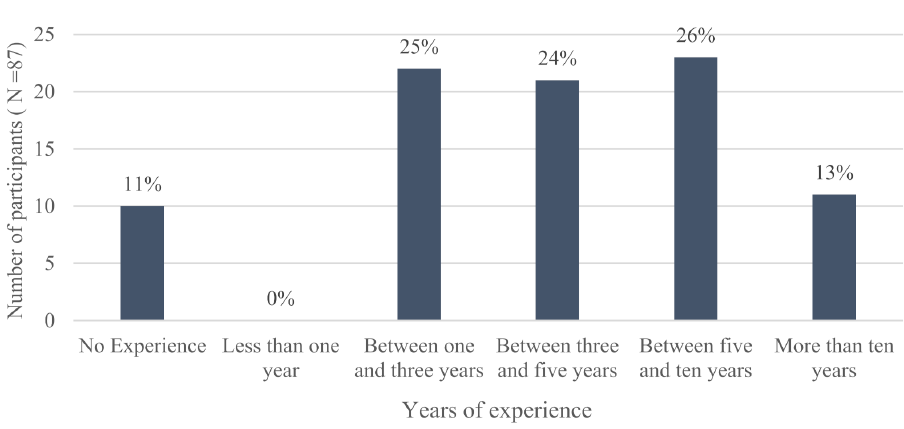
Figure 4. Years of experience of the survey participants with the use of agile